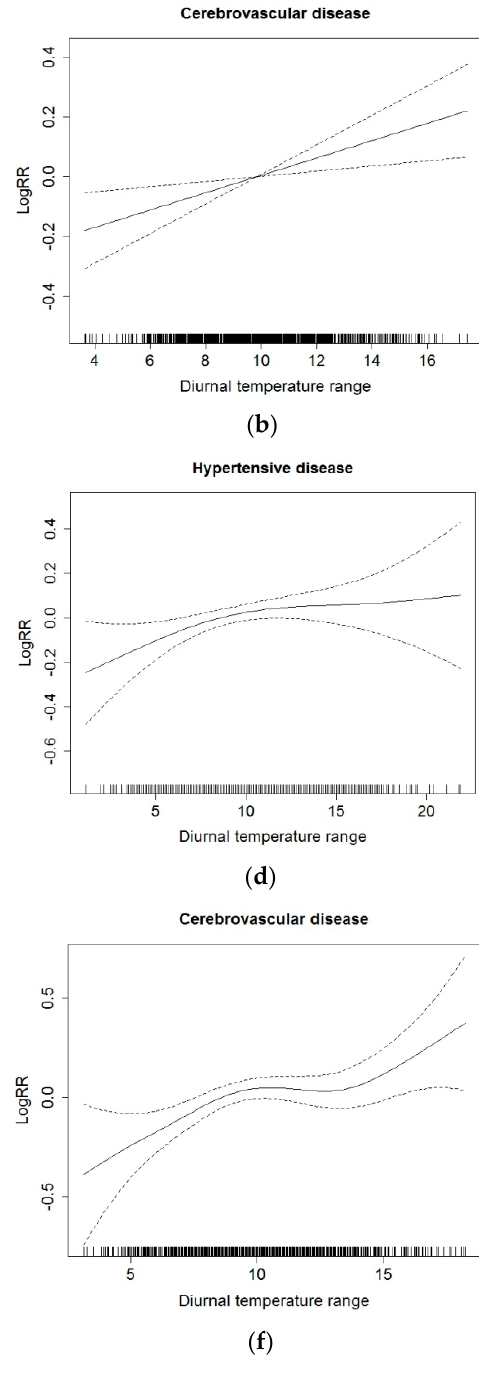
Figure A1. Smoothing plots of DTR against the ER admissions risk of cause-specific cardiovascular disease in the age group 75 years and over. ( a , b ) The relationship between DTR and all cardiovascular disease (L04 day) and cerebrovascular disease (L04 day) ER admissions among males aged 75 years and over; ( c – f ) the relationship between DTR and all cardiovascular disease (L01 day), hypertensive disease (L0 day), ischemic heart disease (L02 day) and cerebrovascular disease (L02 day) ER admissions among females aged 75 years and over. Models were controlled for time trend, DOW, holiday, mean temperature, humidity, wind, atmospheric pressure and air pollutant concentrations. Table A1. Percent increase (mean and 95% CI) of the elderly ER admissions with a 1 °C variation in mean temperature and a 10- μ g/m 3 increase in air pollutant concentrations by gender in Beijing during 2009–2011 a . All Cardiovascular Hypertensive Ischemic Heart Cerebrovascular Covariates Disease Disease Disease Disease Male Temperature b